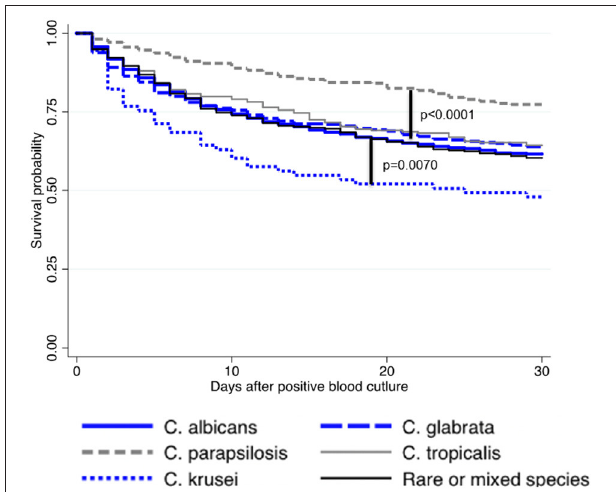
FIGURE 4 | Kaplan–Meier curves illustrating survival rate after incident candidemia according to the species involved in case of single infection due to the five major species or to rare or mixed species (YEASTS program, Paris area, 2004–2017)—(logrank-test p < 0.0001). Survival following infection with C. albicans (solid blue line), C. glabrata (dashed blue line), C. parapsilosis (dashed gray line), C. tropicalis (solid gray line), rare or mixed species (solid black line) are presented. Compared to C. albicans , survival probability was lower with C. krusei ( p = 0.0070) and better with C. parapsilosis ( p < 0.0001).